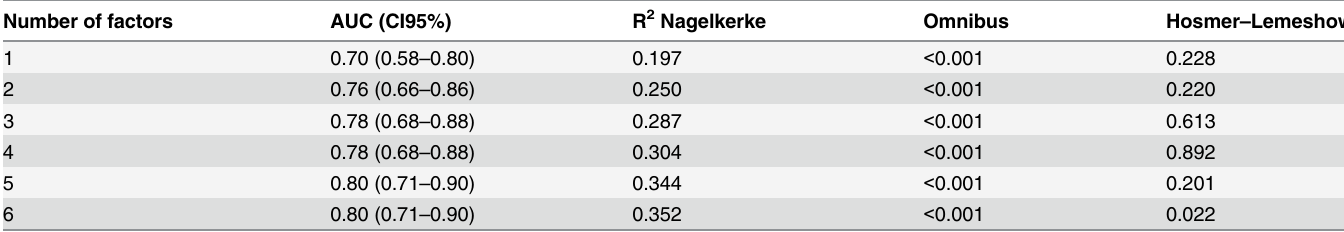
Table 5. System performance evaluation.